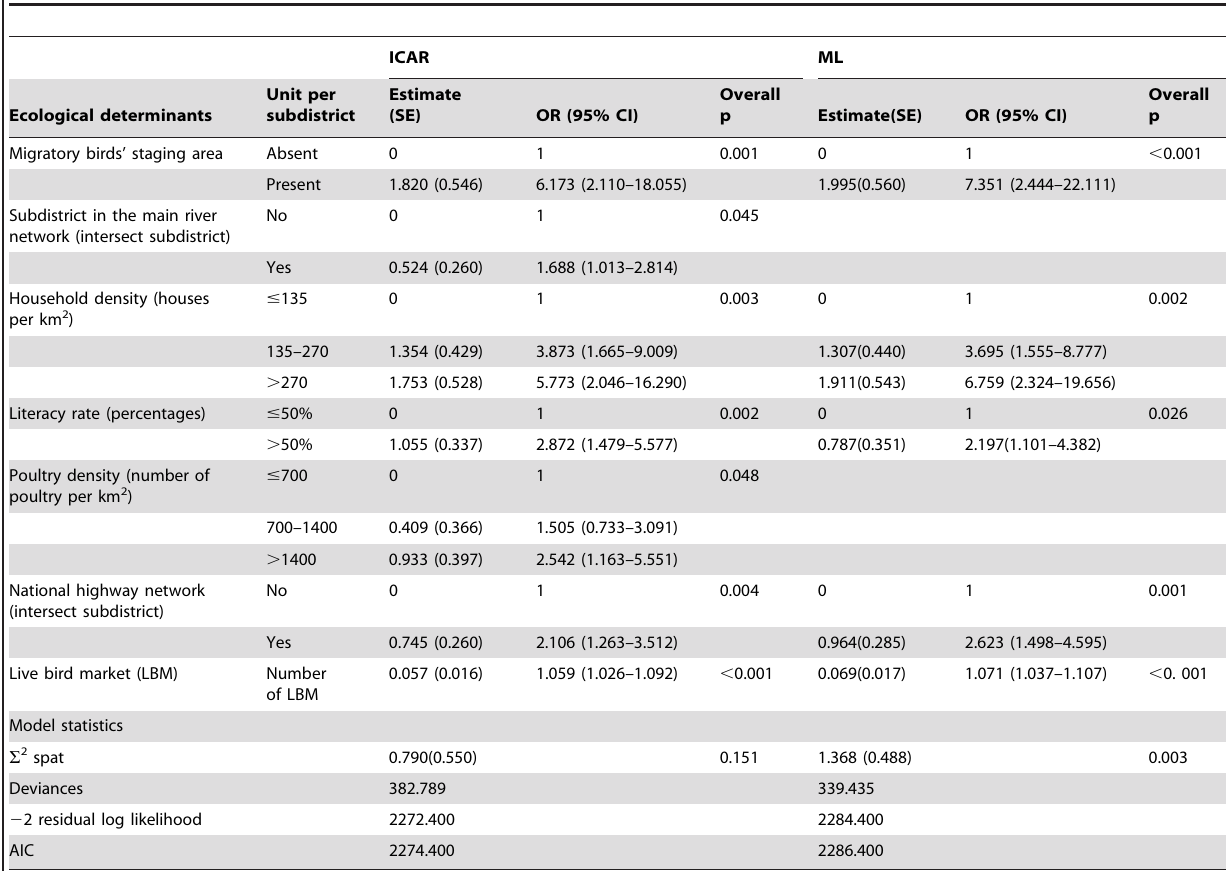
Table 3. Results of the multivariable analysis for ecological determinants, associated with risk of HPAI-H5N1 outbreaks at subdistrict level in